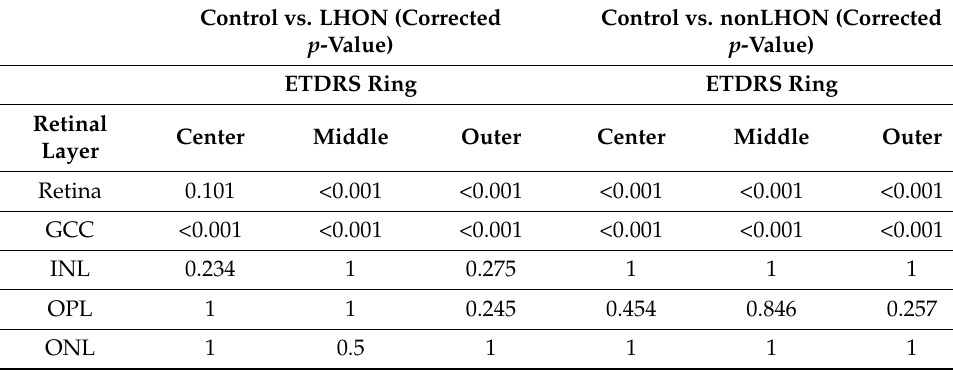
Table 1. Comparison of the mean difference in retinal thickness between control group. against LHON and nonLHON group using Welch’s t-test ( p -values).